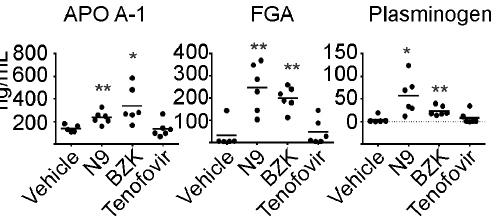
Figure 5. ELISA analysis of rabbit proteins in vaginal brush samples increased in response to treatment with N9 or BZK. Statistical analysis were performed using a two-tailed Student’s T-test of N9 and BZK samples compared to vehicle controls (**=p # 0.01, *=p # 0.05, NS=not